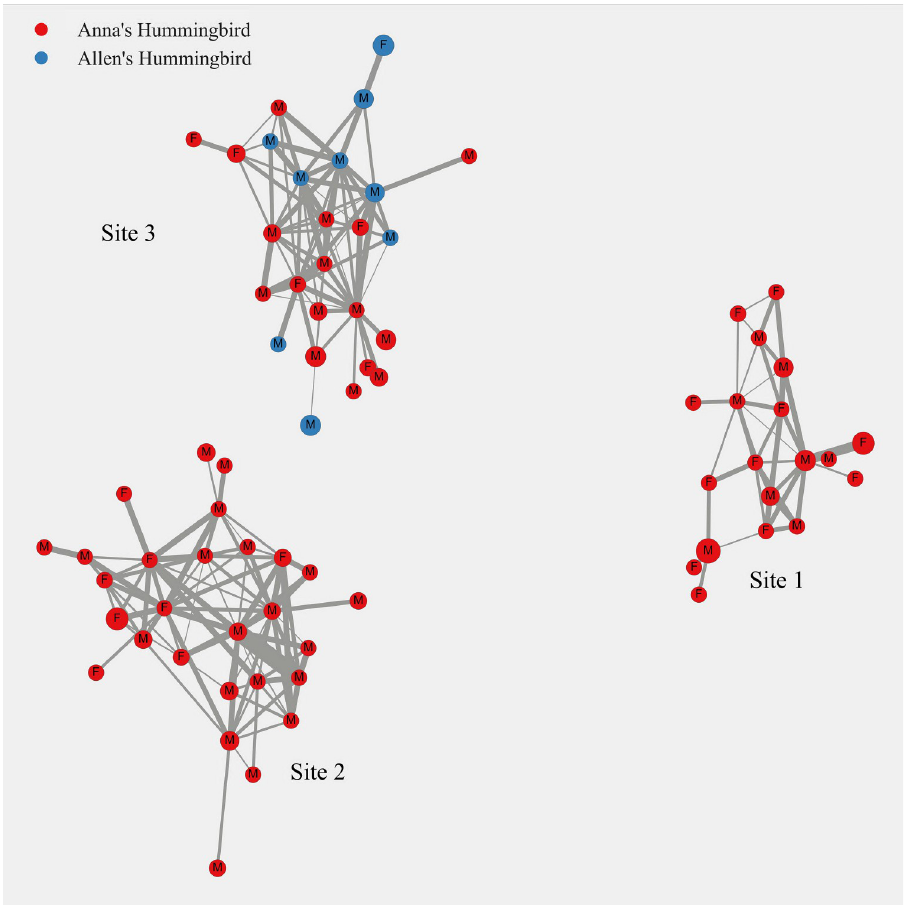
Fig 10. Contact network of tagged Anna’s (pink nodes) and Allen’s hummingbirds (green nodes). The sex of the hummingbirds indicated by M for males and F for females. The size of the node is proportional to the degree of the interaction. Edges represent time spent together at the feeding station and the width of the edge width is proportional to the time spent together.